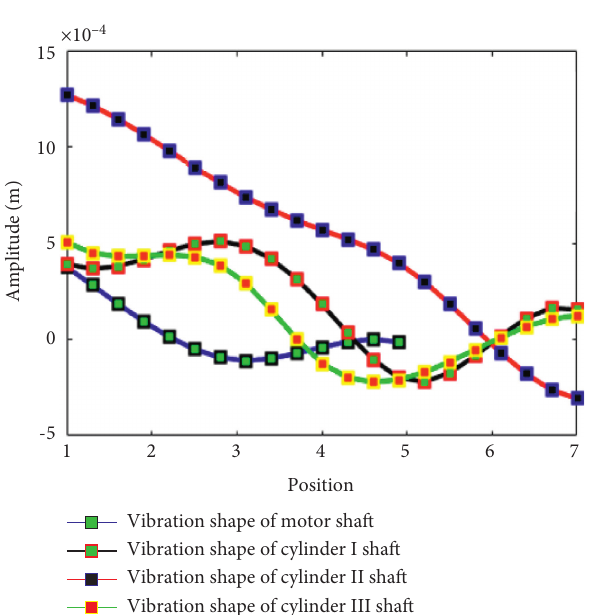
Figure 13: Vibration shape of multicylinder system at t � 0.